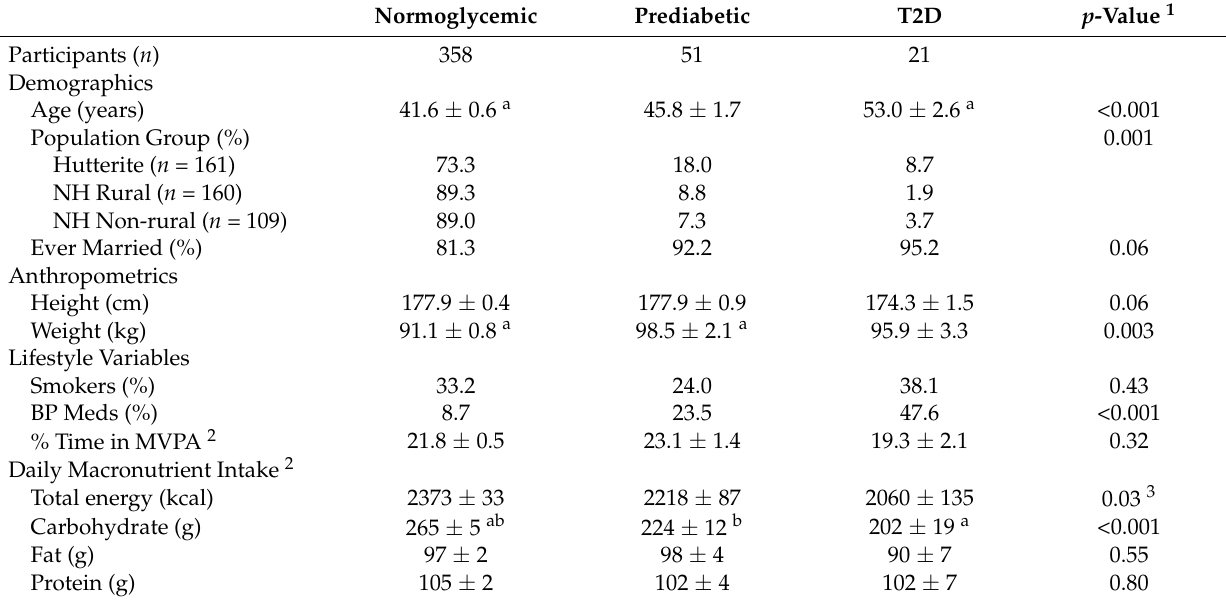
Table 1. Baseline characteristics of the 430 men from the South Dakota Rural Bone Health Study cohort. NH: